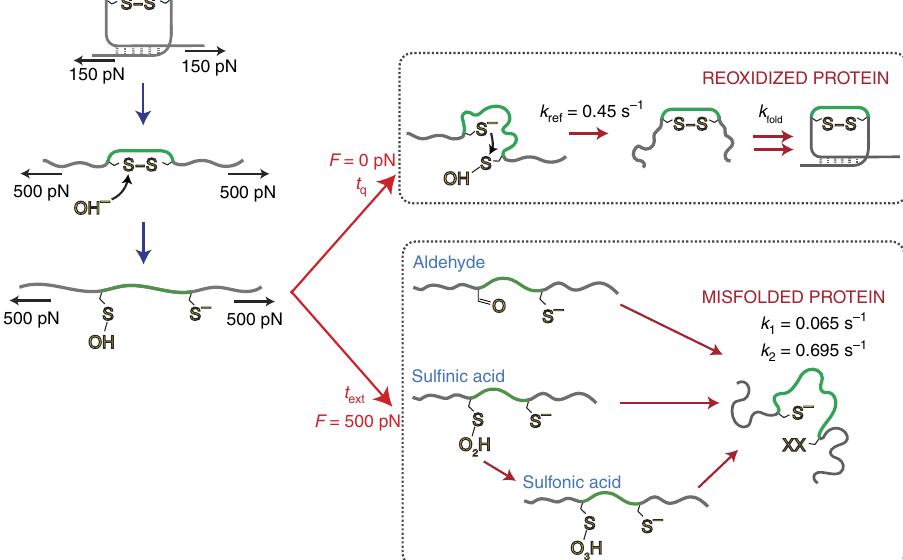
Figure 6 | Kinetic scheme for the force-triggered, conformation-dependent reactivity of sulfenic acid and its implications for oxidative protein folding. On the application of mechanical force, the hydroxide anions rupture a protein disulfide bond, creating a sulfenic acid and a thiolate. In the absence of force ( F ¼ 0 pN) during the quench time ( t q ) the sulfenic acid moiety remains cryptic in the protein’s collapsed state. Under these conditions, the longer t q , the higher the probability the thiolate anion can attack the sulfenic acid moiety (in the absence of dimedone), thus creating a disulfide bond with an associated rate of k ref ¼ 0.45s (cid:2) 1 . The reformation of the disulfide bond triggers the ‘instantaneous’ refolding of the protein (essentially set by the disulfide bond reformation rate). By contrast, when the protein is reduced and stretched at high force ( F ¼ 500pN), sulfenic acid is fully exposed to the solvent